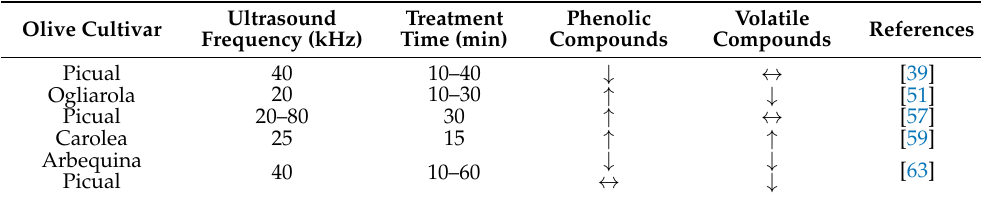
Table 2. Impact of HPU-assisted extraction on olive oil phenolic and volatile compounds concentra- tion, as compared to traditional extraction